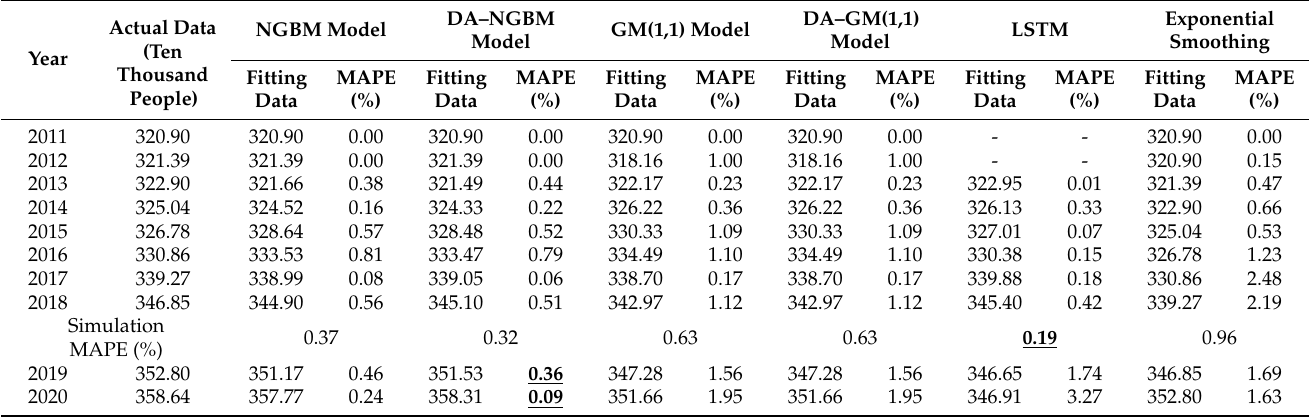
Table 5. Comparison of fitting and predicted values of the male population of Nanjing city from 2011 to